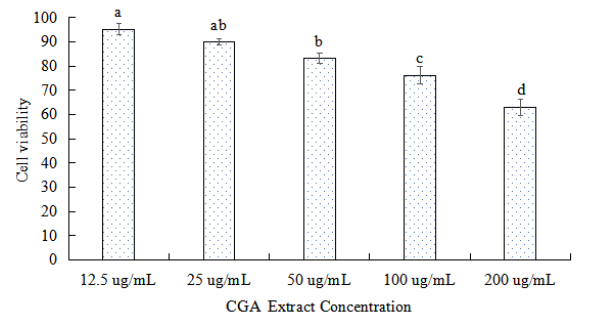
Fig. 1: Cell viability of BMEC induced by CGA extract after 24 h by CCK-8